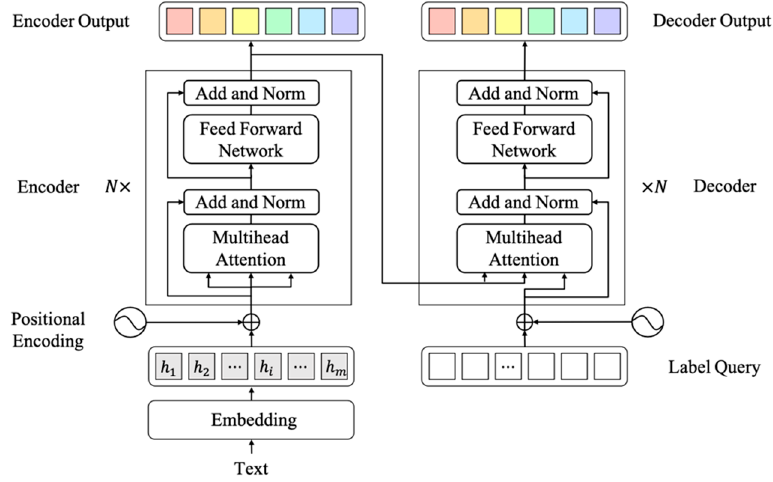
Figure 2. The overall structure of the encoder and decoder.